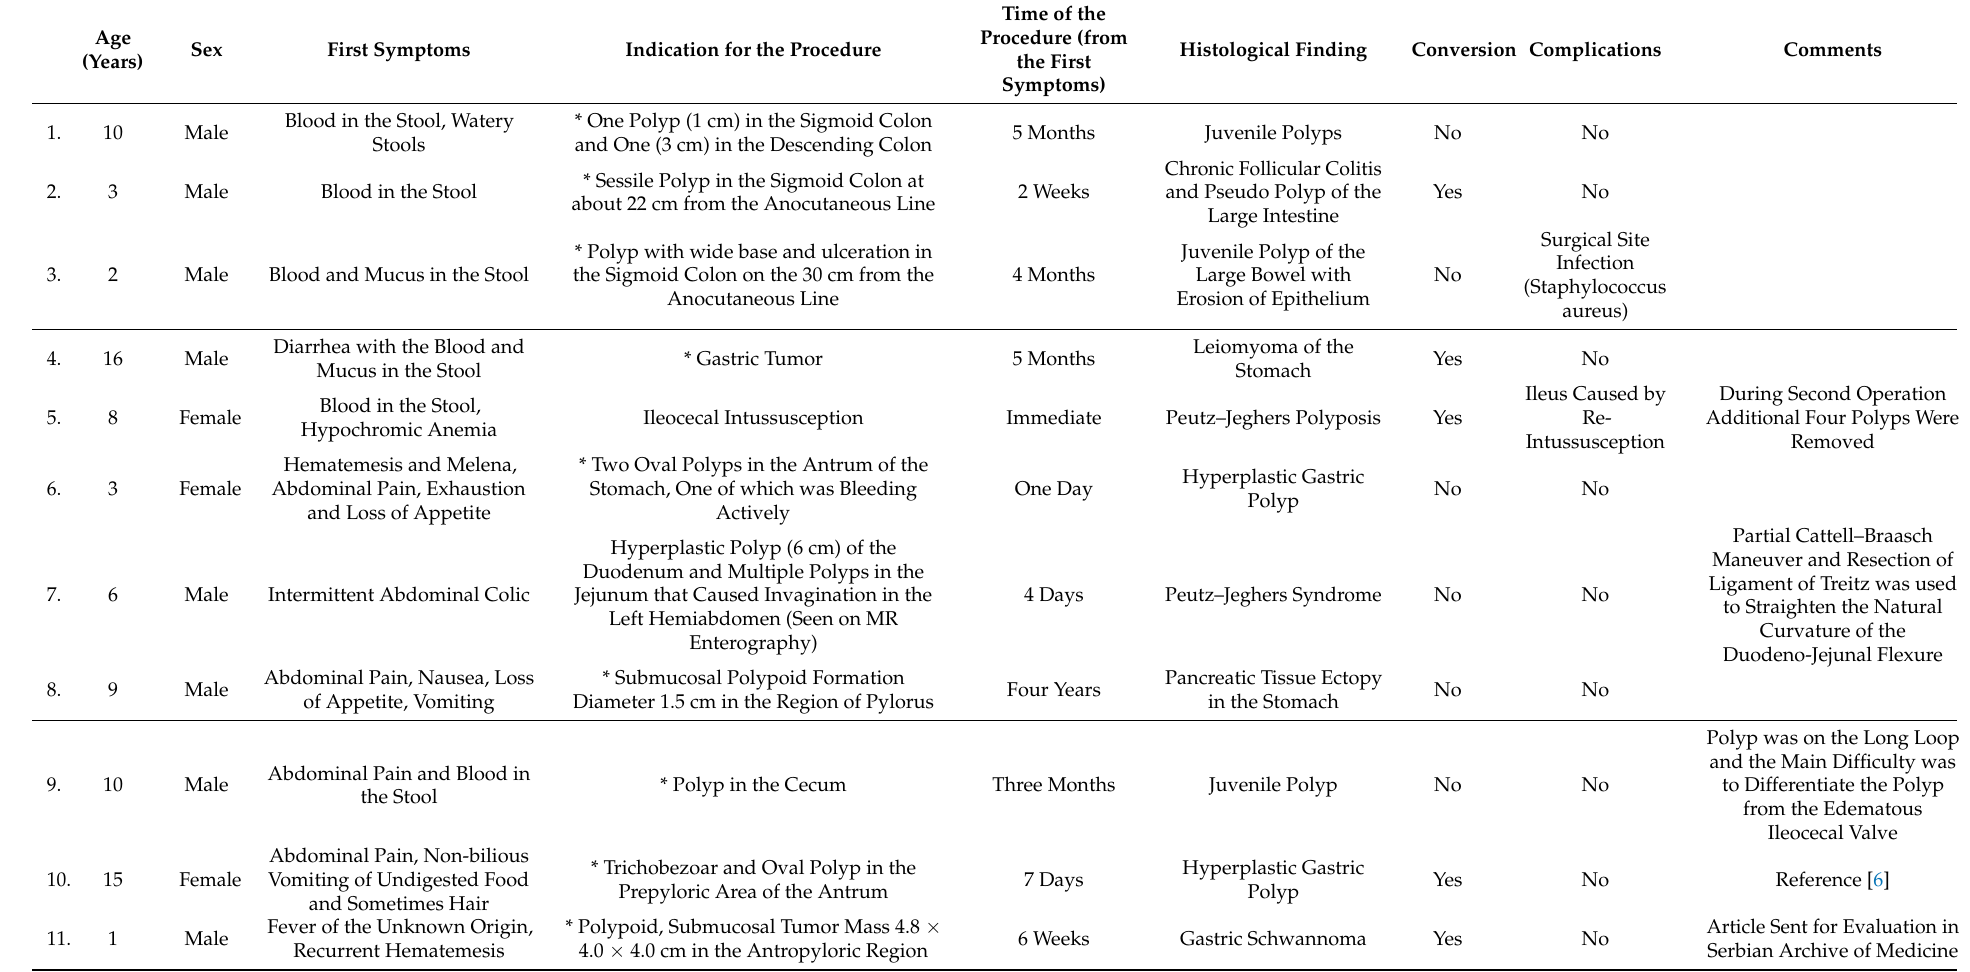
Table 1. Demographic characteristics, symptoms, diagnostic procedures, pathohistological finding, necessity for conversion and complications in patients in whom laparoscopic–endoscopic “rendezvous” procedure was